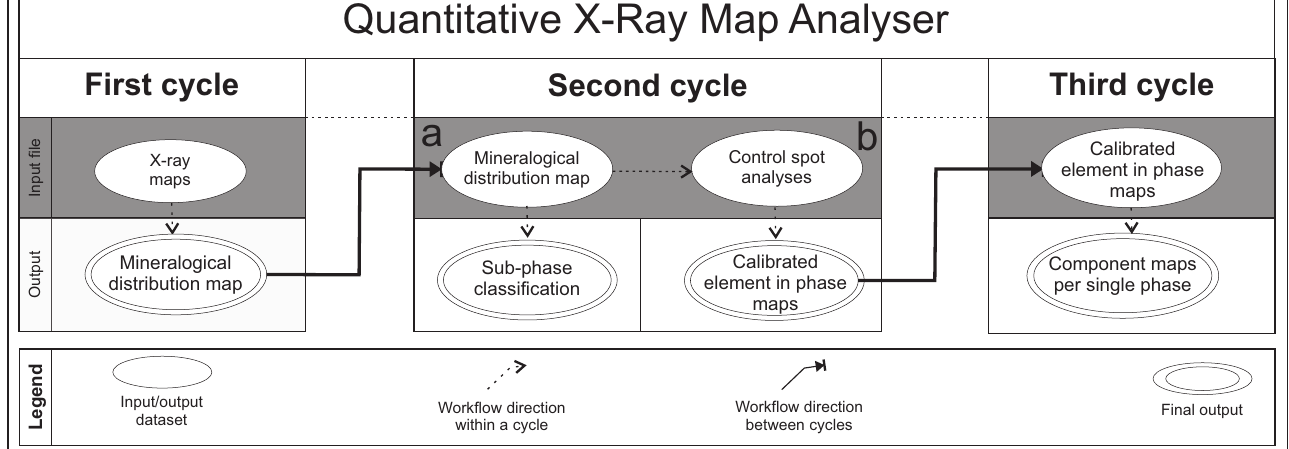
Figure 3. Simplified flow chart of the Quantitative X-ray Map Analyzer workflow (modified after [18]: First cycle: classification of the main recognized mineral phase. Second cycle: ( a ) potential sub-phase classification; ( b ) pixel calibration in a.p.f.u. Third cycle: the transformation of calibrated a.p.f.u. maps into end member maps for solid solution mineral